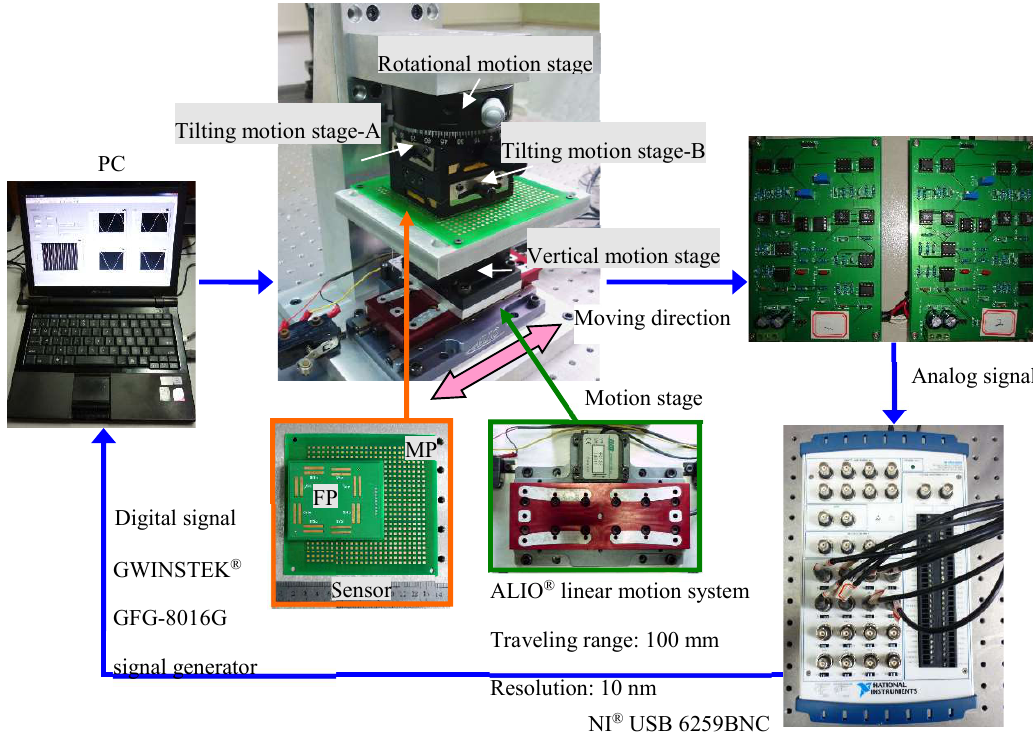
Figure 4. Test bench of the proposed encoder-like capacitive positioning system.